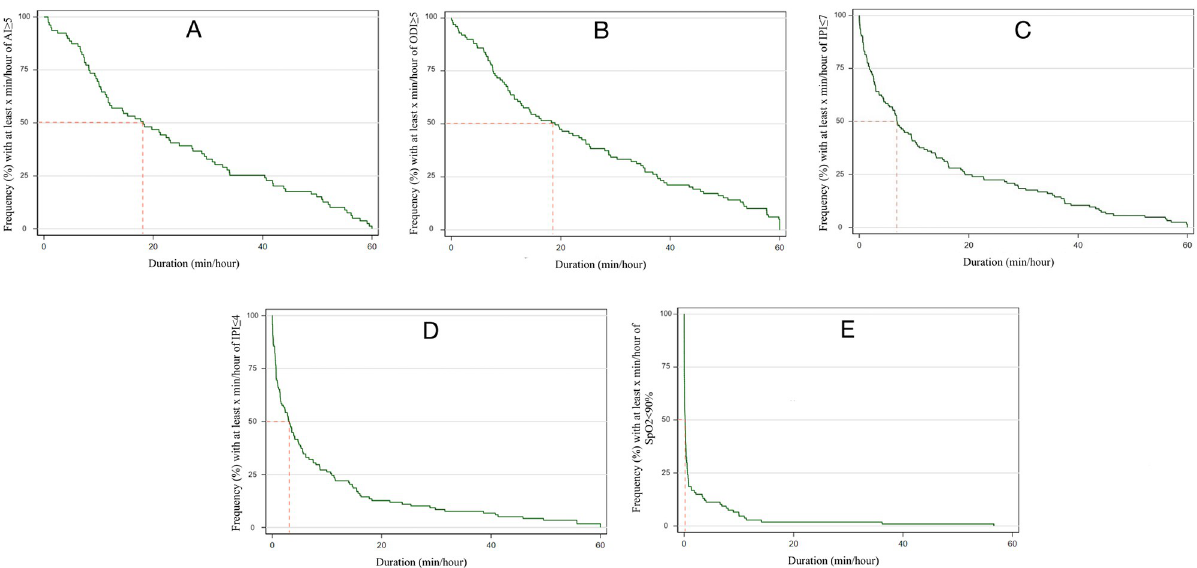
Fig 3. Frequency distribution of the proportion of recorded time with deranged AI, ODI, IPI, and SpO 2 expressed as average minutes per hour of monitoring. A) Frequency distribution of the proportion of recorded time with AI � 5. B) Frequency distribution of the proportion of recorded time with ODI � 5. C) Frequency distribution of the proportion of recorded time with IPI � 7. D) Frequency distribution of the proportion of recorded time with IPI � 4. E) Frequency distribution of the proportion of recorded time with SpO 2 < 90%. The red line represents the points at which half the population experience derangements in AI, ODI, IPI, or SpO 2 . AI = apnea index; the average number of apnea events (absence of respiratory activity for � 10 seconds) per hour. ODI = oxygen desaturation index, the number of times that oxygen saturation drops by � 4% from baseline within a 240 second period. IPI = integrated pulmonary index, a global assessment of cardiorespiratory status incorporating all available monitoring results from the Capnostream monitor, with 10 reflecting normal physiology and 1 being the most deranged.